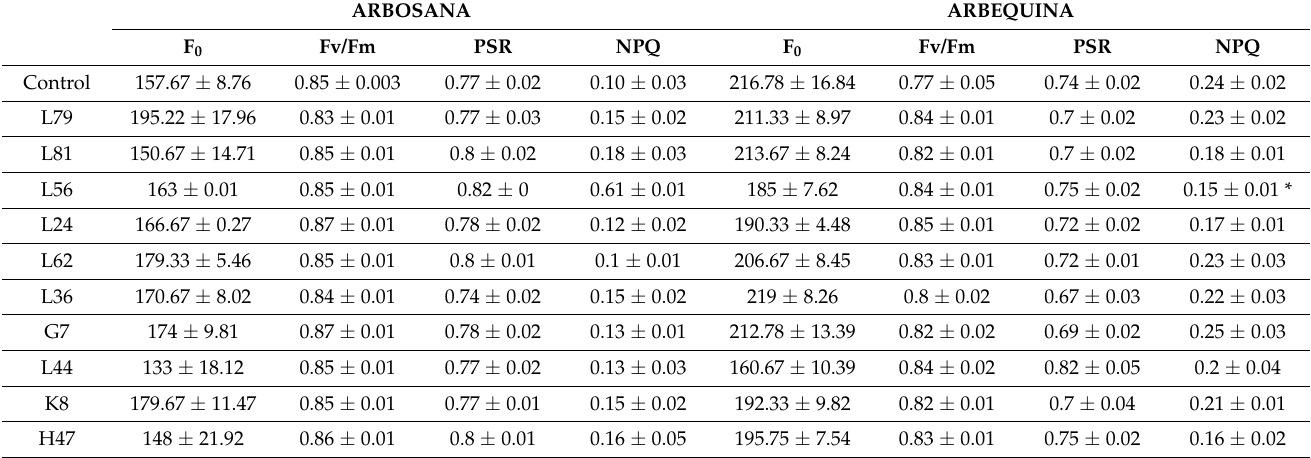
Table 2. Photosynthetic parameters of plants from AS and AQ, inoculated with the 10 strains and the non-inoculated controls. Minimum florescence (F 0 ). Maximum photosynthetic potential of PSII (Fv/Fm). Photosynthetic quantum yield (PSR) and non-photochemical quenching (NPQ). Values are the average ± SE (n = 3). Asterisks indicate significant differences according to t -Student test p < 0.05.